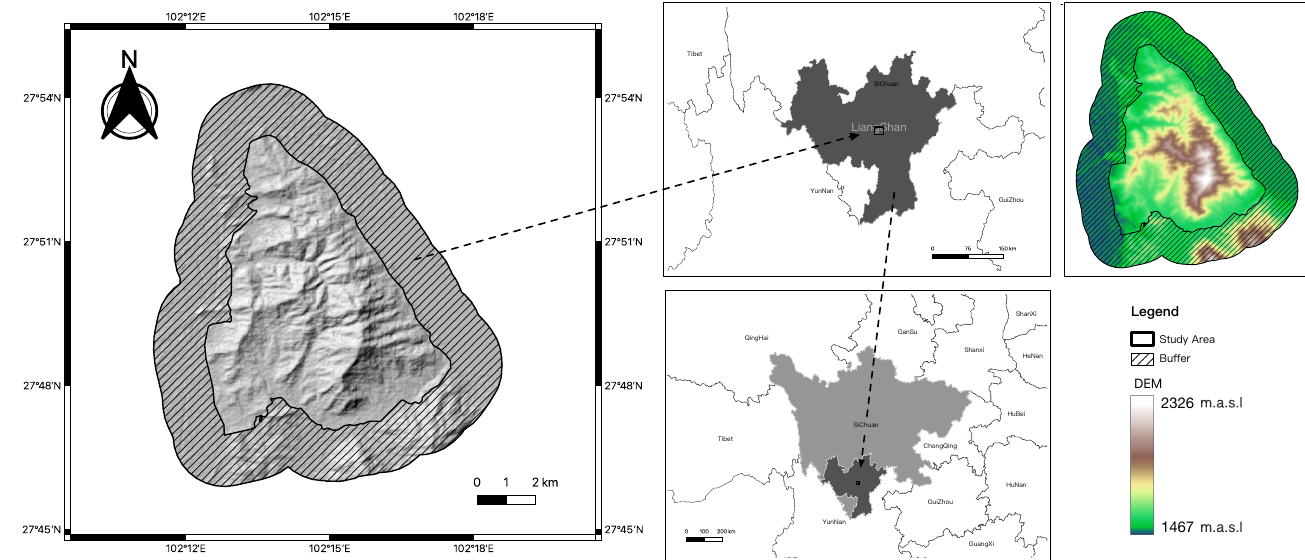
Figure 1. Study area, which is located in Liangshan, Sichuan, China. The left image is the aspect of the study area, the middle images are the overall orientation map of the study area, and the upper right corner is the Digital Elevation Model of the study area which from ASTGTMv003 series of